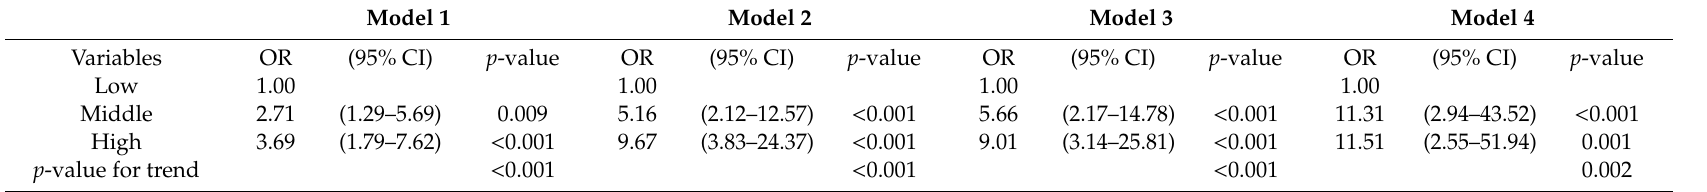
Table 3. Association between the tertiles of the HOMA-IR levels and a high FRS (FRS ≥ 20%).